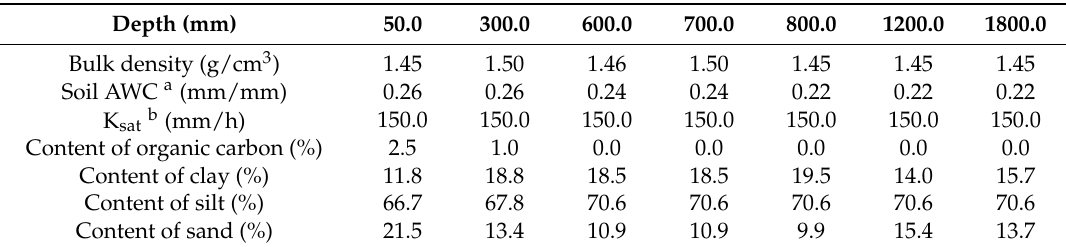
Table 4. Soil parameters used in the simulation